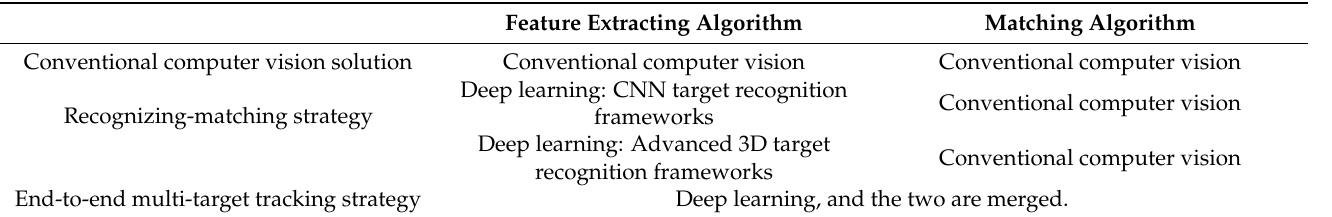
Table 4. Recognizing–matching strategy and end-to-end multi-target tracking